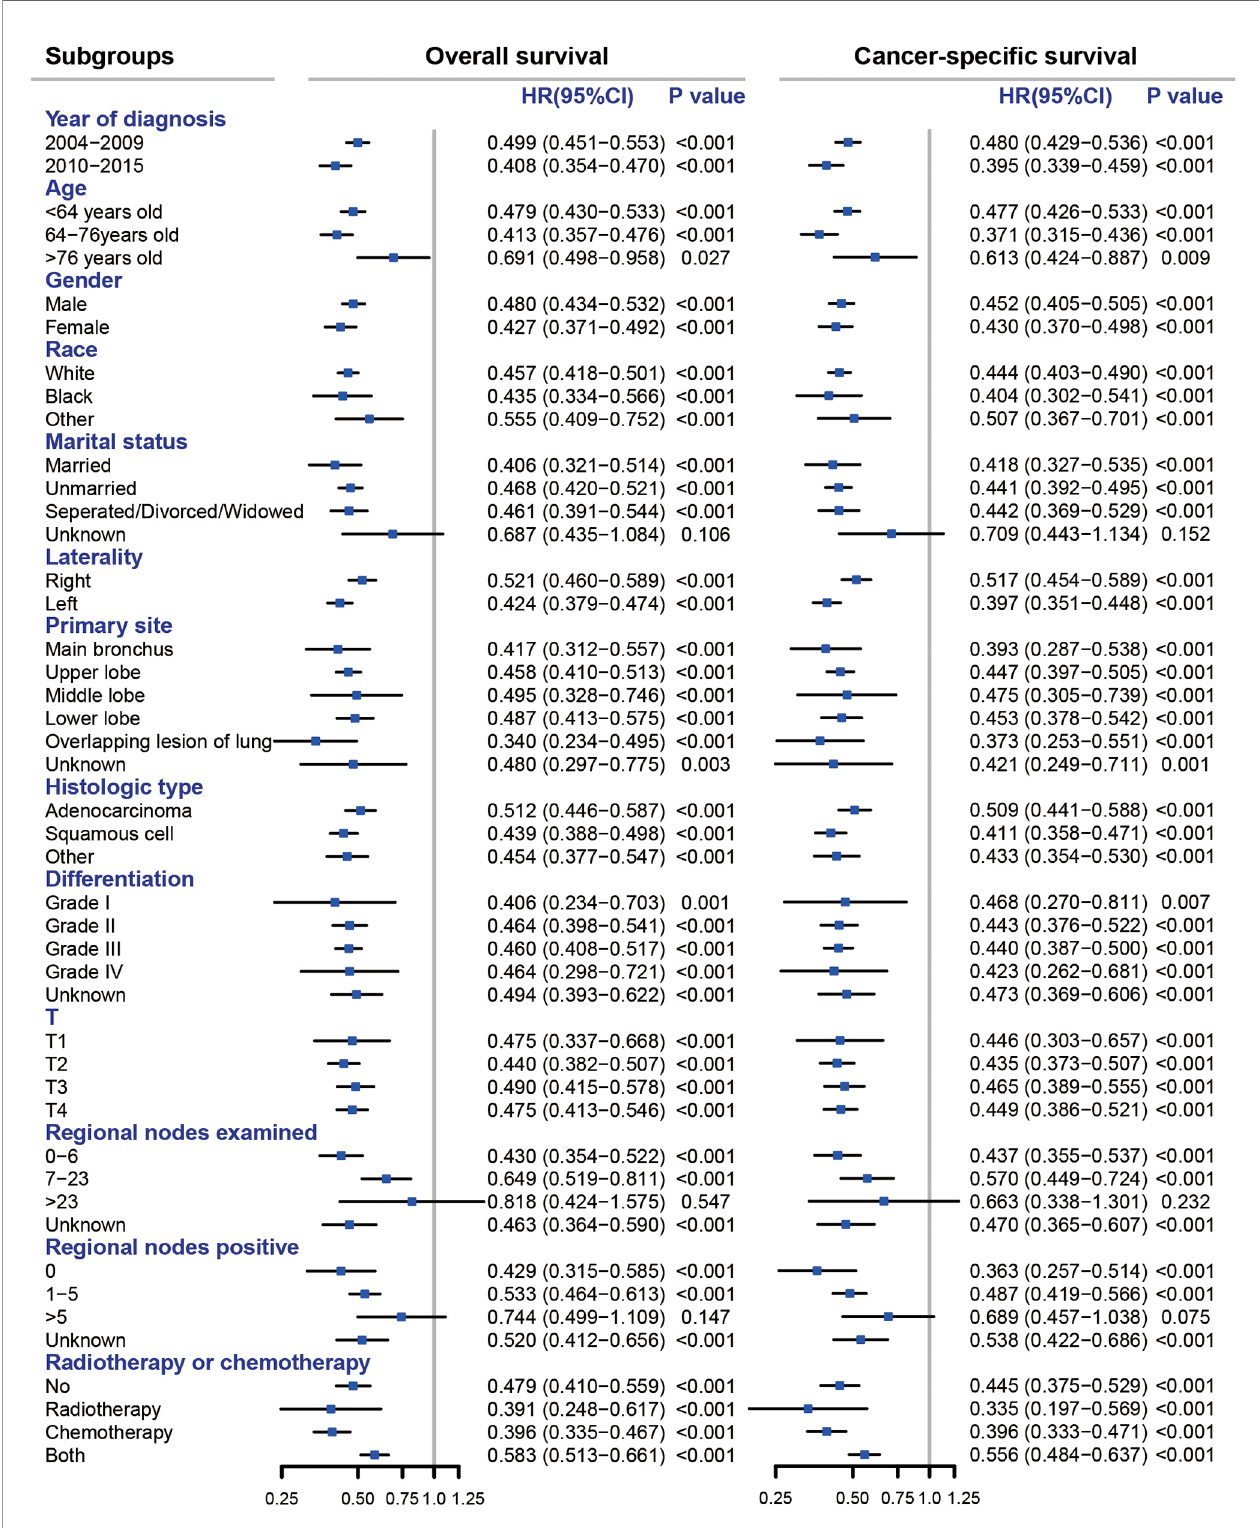
FIGURE 2 | Subgroup analyses comparing pneumonectomy with no surgery for stage T1 – 4N2M0 NSCLC patients. All HRs were calculated by adjusting year of diagnosis, age, gender, race, marital status, laterality, primary site, histologic type, differentiation, T, and radiotherapy or chemotherapy except for the subgroup variable itself. NSCLC, non-small cell lung cancer; HR, hazard ratio; CI, con fi dence interval.